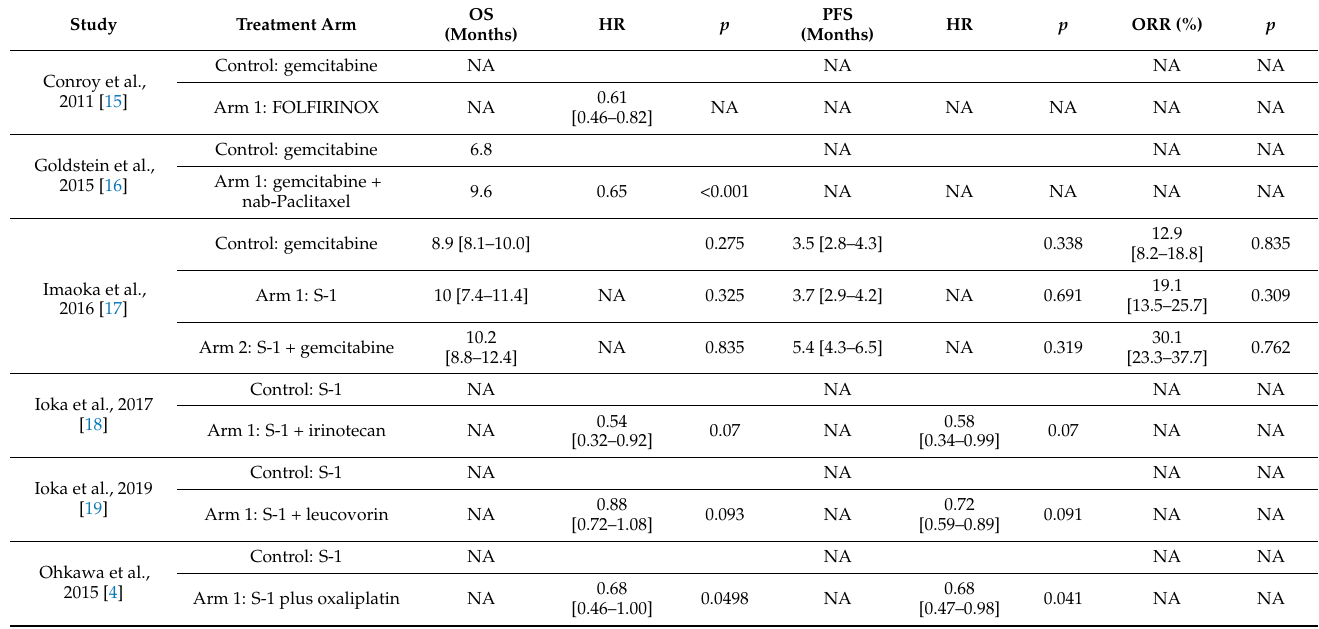
Table 4. Subgroup analysis of young patient outcomes including OS, PFS, and ORR along with 95% confidence intervals where provided.